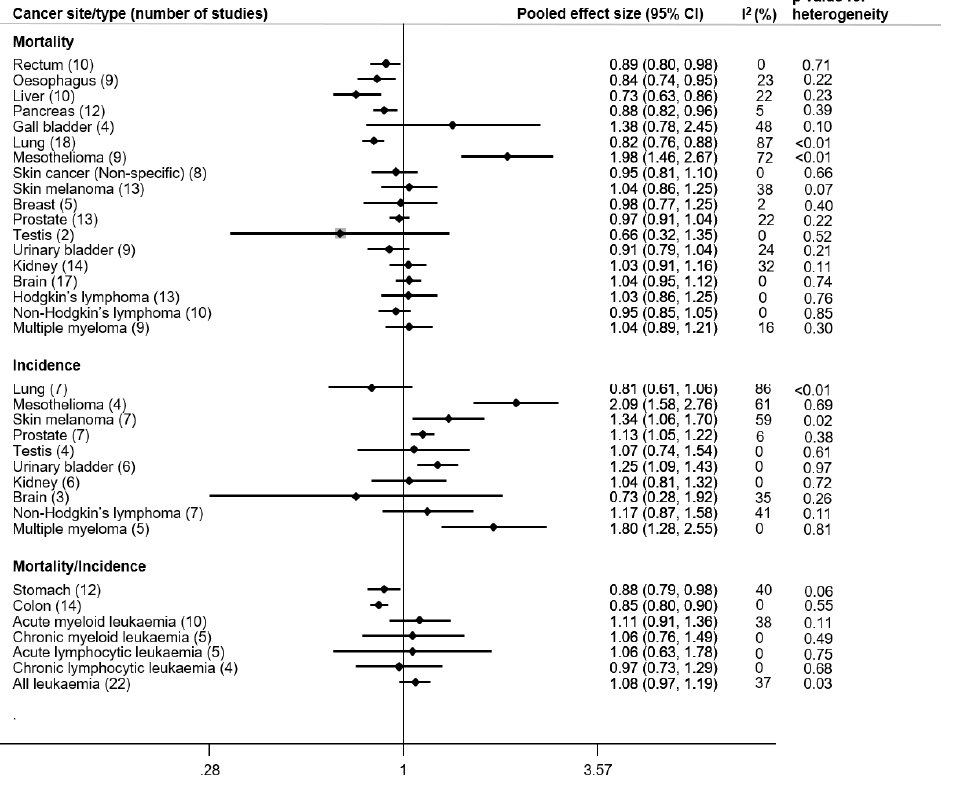
Figure 2. Forest plot of pooled effect sizes and heterogeneity in cohort studies evaluating cancer incidence and mortality among petroleum industry workers sorted by ICD.